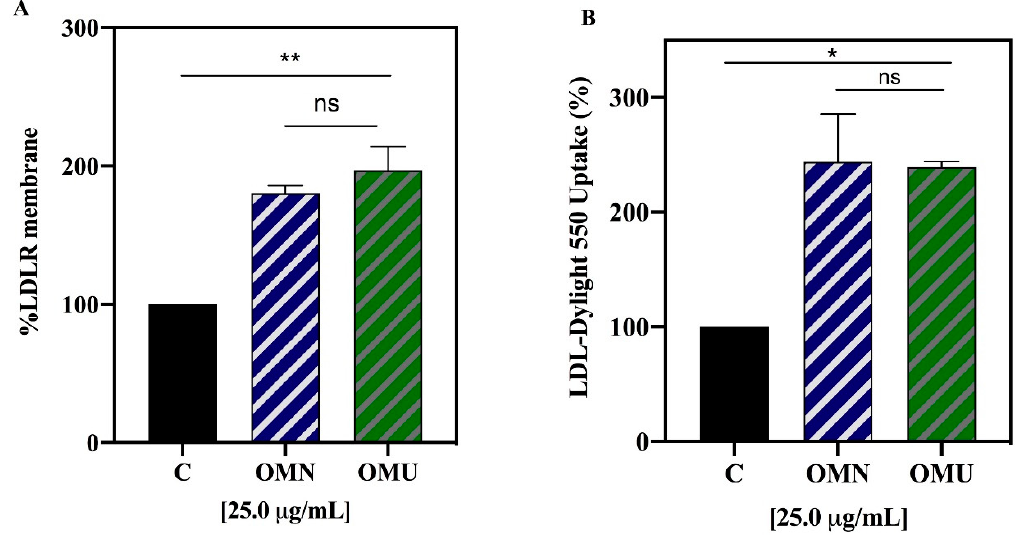
Figure 7. Modulation of the LDLR on HepG2 cell surface and uptake of environmental LDL. ( A ) LDLR protein levels on HepG2 cell surface evaluated by in cell western. ( B ) Uptake of fluorescent LDL from the environment by HepG2 cells. Data represent the mean ± s.d. of five independent experiments performed in triplicate. All the data sets were analyzed by One-way ANOVA and OMN vs OMU by t-student test. (*) p < 0.5; (**) p < 0.001. ns: not significant, C: control sample.